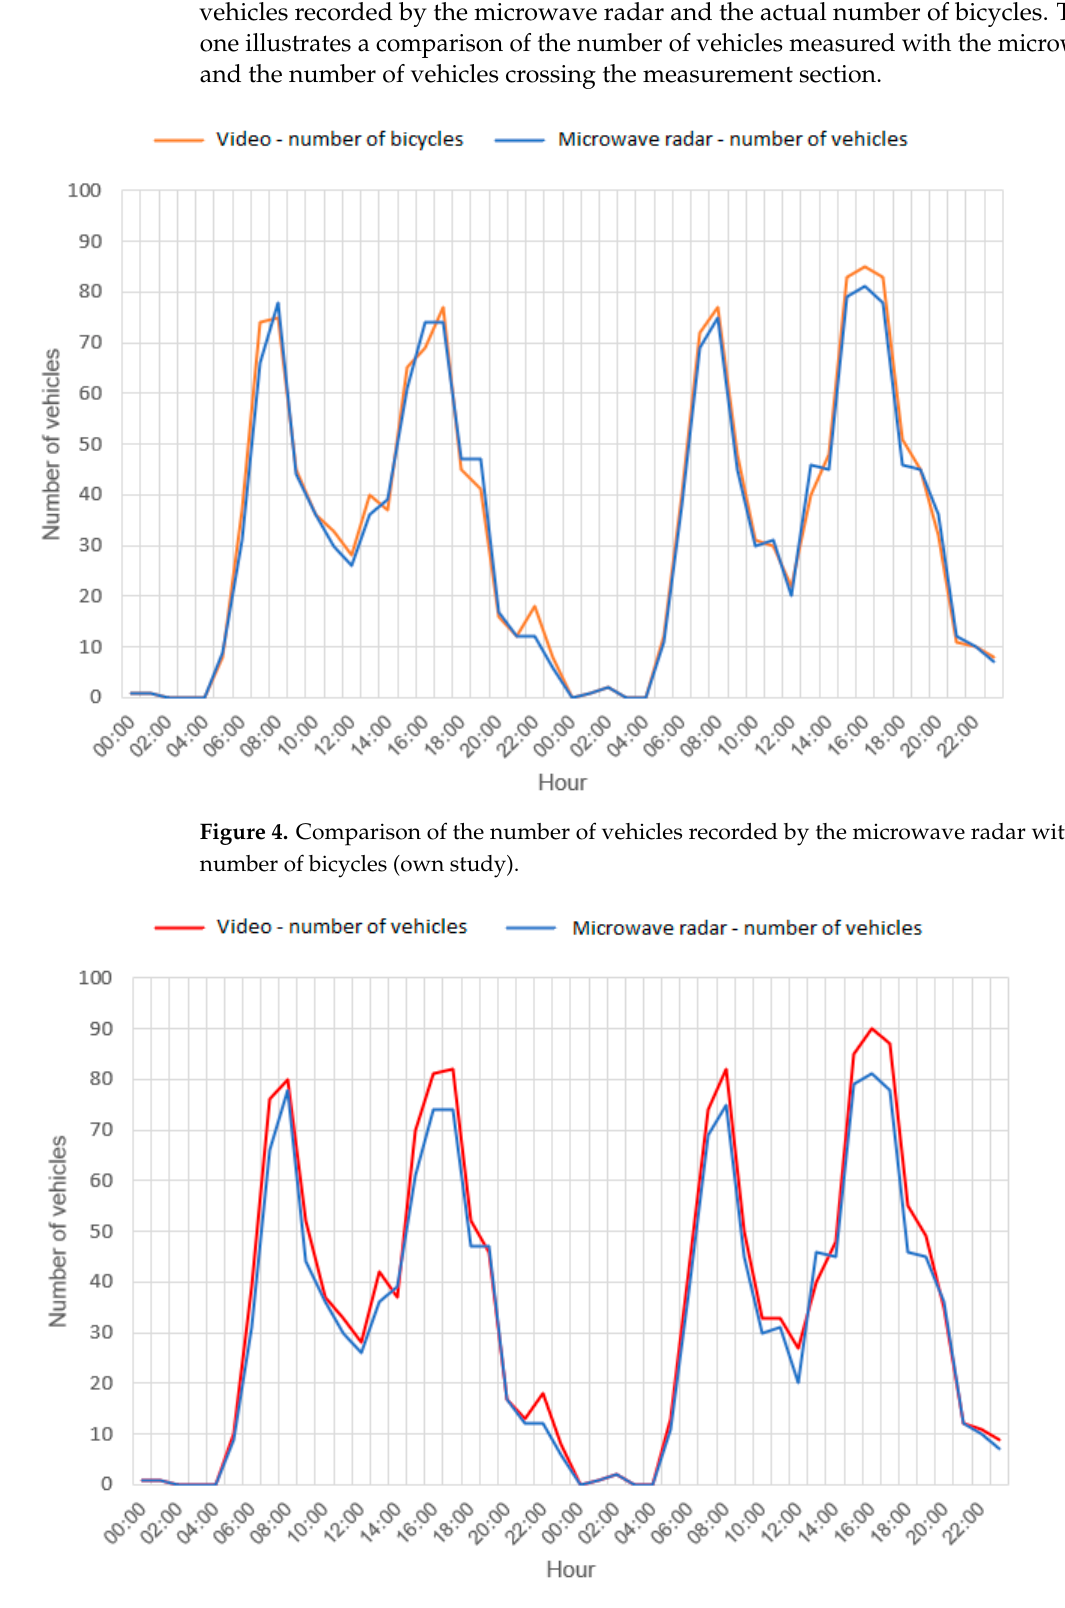
Figure 5. Comparison of the number of vehicles recorded by the microwave radar with the actual number of vehicles crossing the measurement section (own study).